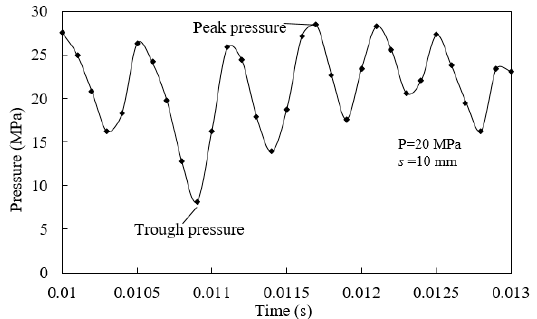
Figure 6. Pressure fluctuations during a period of time.